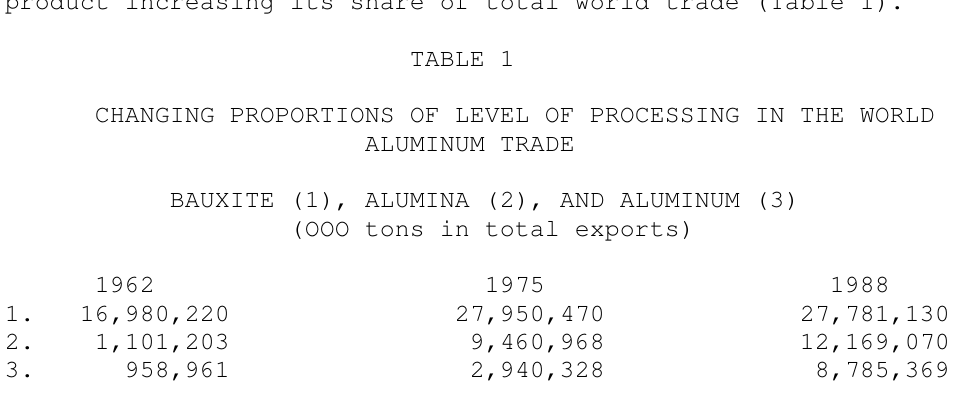
CHANGING PROPORTIONS OF LEVEL OF PROCESSING IN THE WORLD ALUMINUM